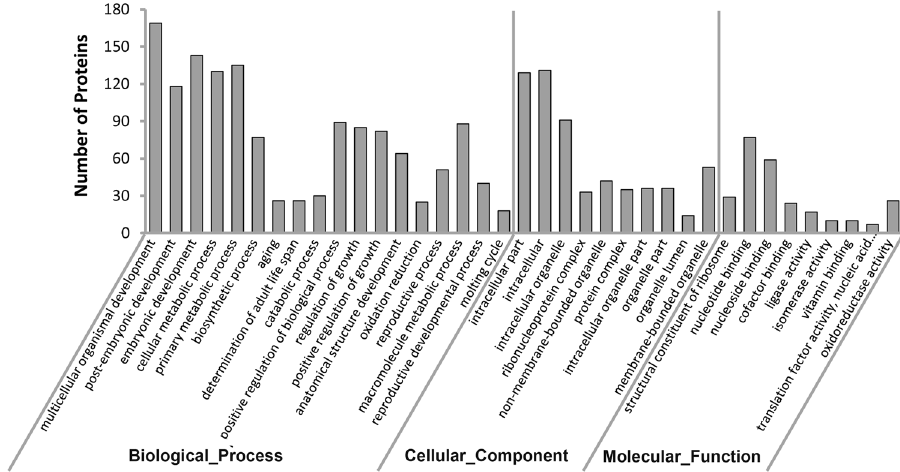
Figure 3. A histogram showing the enriched GO terms (Biological_Process, Cellular_Component, and Molecular_Function) for the DEPs identified with iTRAQ.